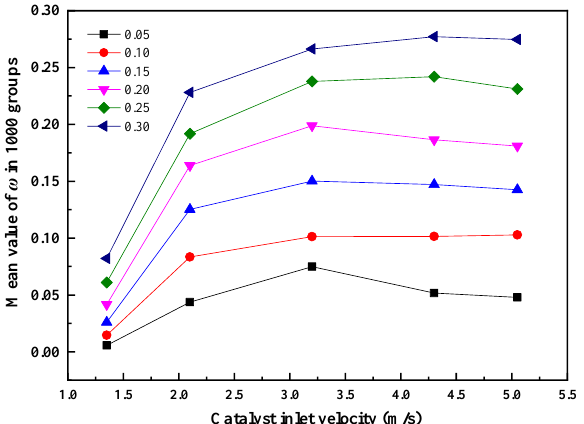
Figure 31. Relationship between mean velocity and mean deviation of center concentration under different relative standard deviations of velocity.